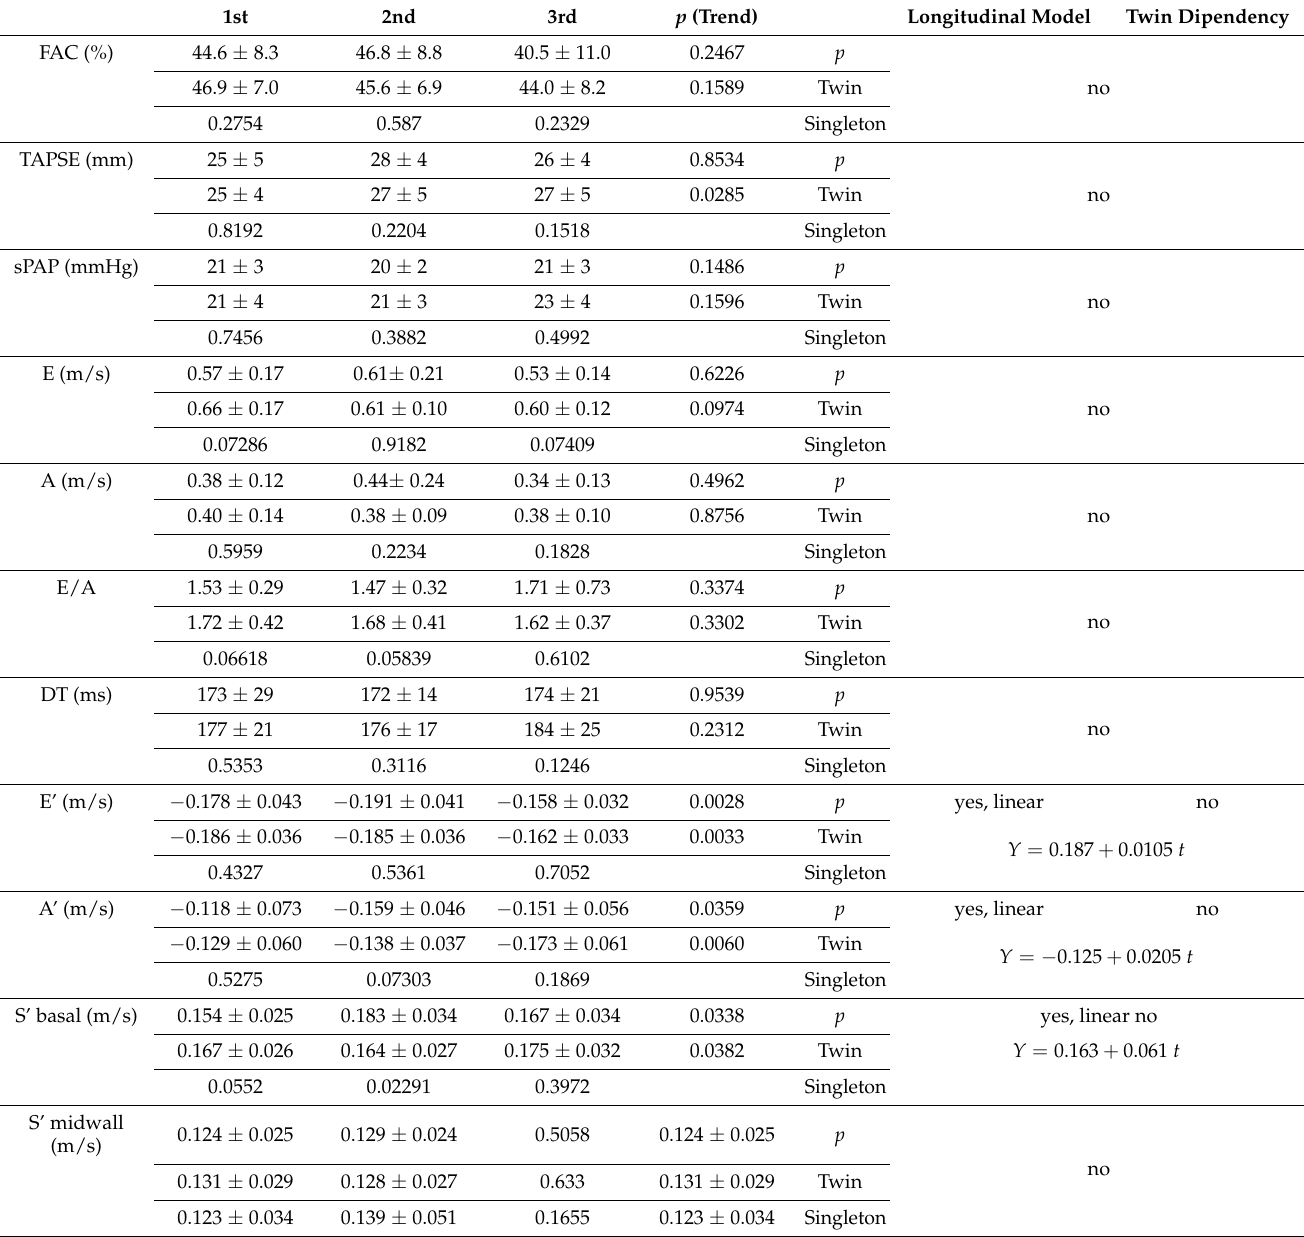
Table 1. Right ventricular findings obtained by echocardiography at each trimester in twin versus singleton